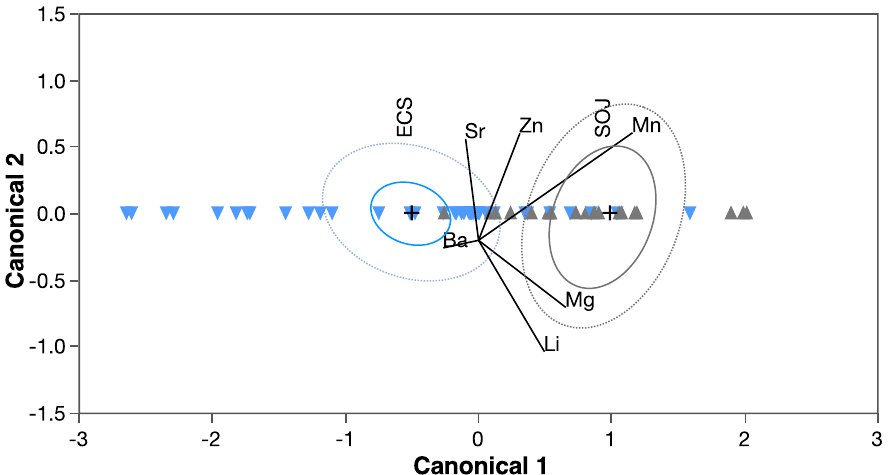
Figure 7. Canonical discriminant analysis based on otolith element:Ca ratios of age-0 Pacific bluefin tuna collected from the East China Sea (ECS = blue) and Sea of Japan (SOJ = grey). 95% confidence ellipse (solid line) around each centroid denoted with + symbol and normal 50% ellipse (dashed line) shown. Since classification variable has only two levels, points are plotted against the single canonical variable (Canonical 1) and canonical weights for each covariate relate to this variable only. Biplot vectors from each centroid indicate the influence of each element:Ca ratio (Li:Ca, Mg:Ca,m Mg:Ca, Zn:Ca, Sr:Ca, Ba:Ca) on regional discrimination. Rays shown with a vertical component only for improved separation but all are relative to Canonical 1